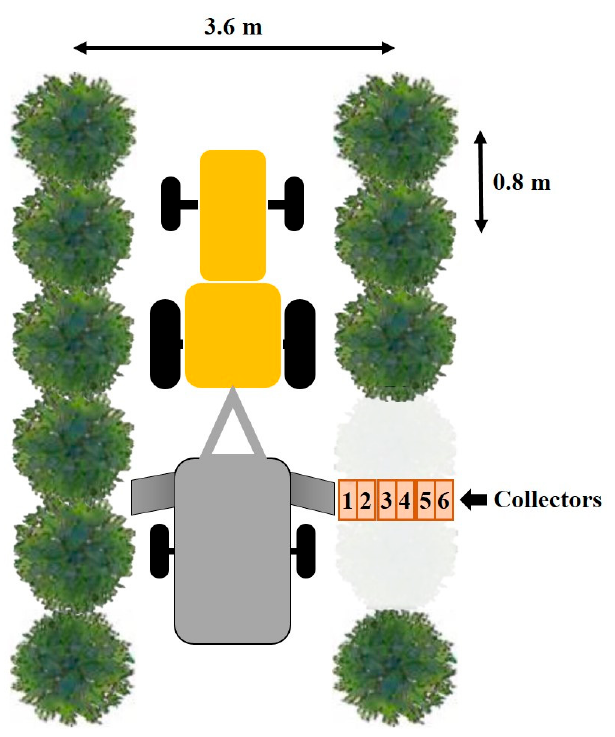
Figure 3. Scheme representing collector placement under the coffee trees.